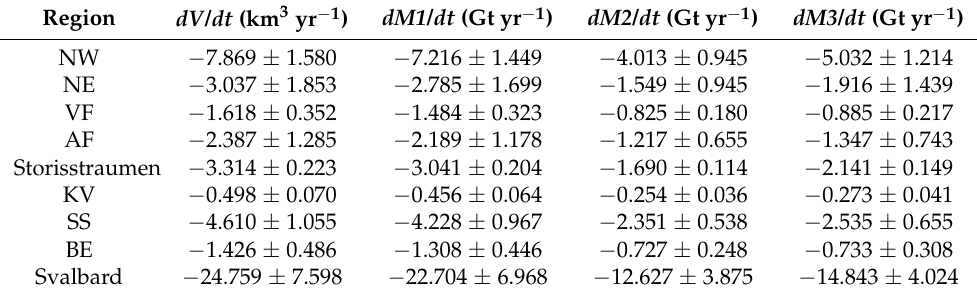
Table 2. Volume ( dV / dt ), and mass change ( dM1 / dt , dM2 / dt and dM3 / dt ) rates for each subregion and the whole of